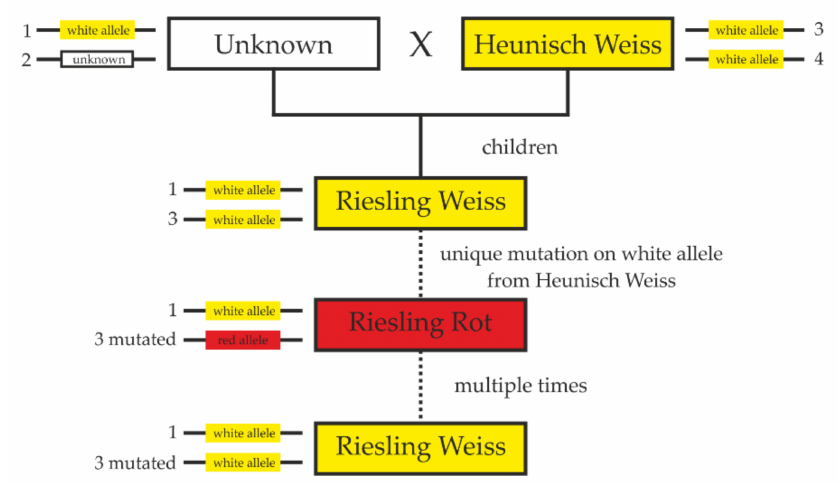
Figure 4. Pedigree tree of ‘Riesling’ based on parental haplophase assignment using SSR marker data along chromosome